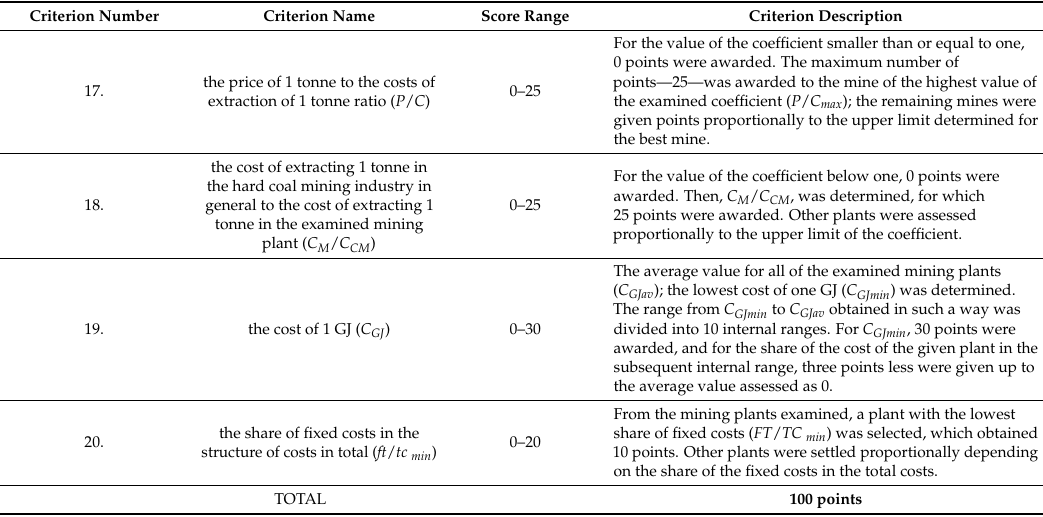
Table 4. Principles for assessing economic